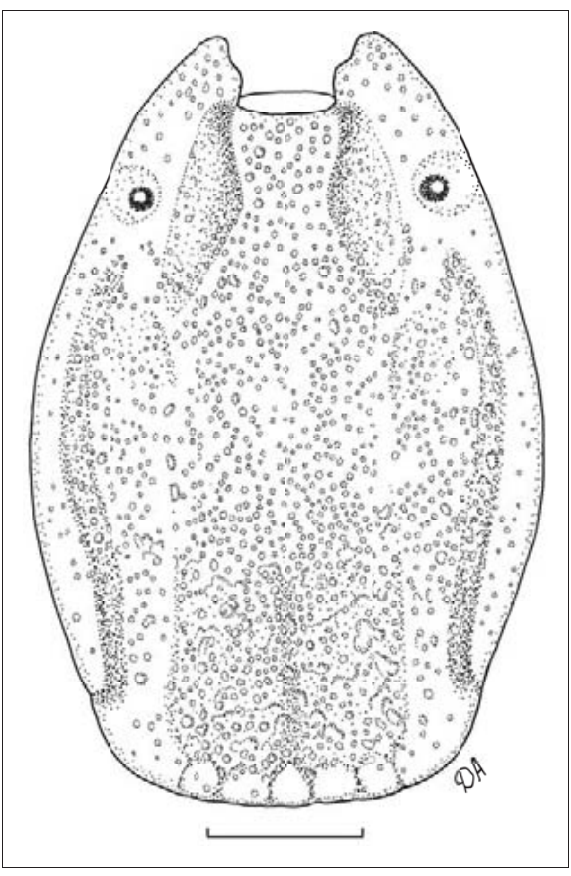
FIG. 1 Hyalomma glabrum , male, conscutum. Bar = 1